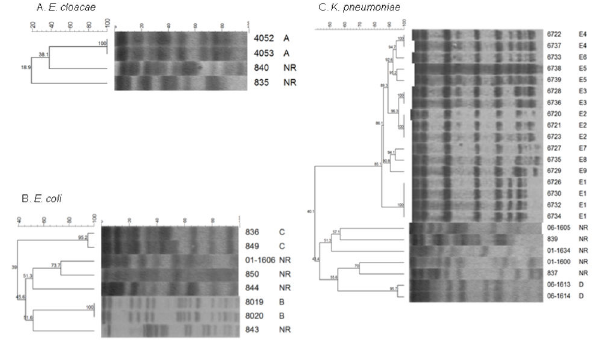
Figure 1. PFGE and dendrogram analysis of PMQR- positive Enterobacteriaceae pediatric isolates.